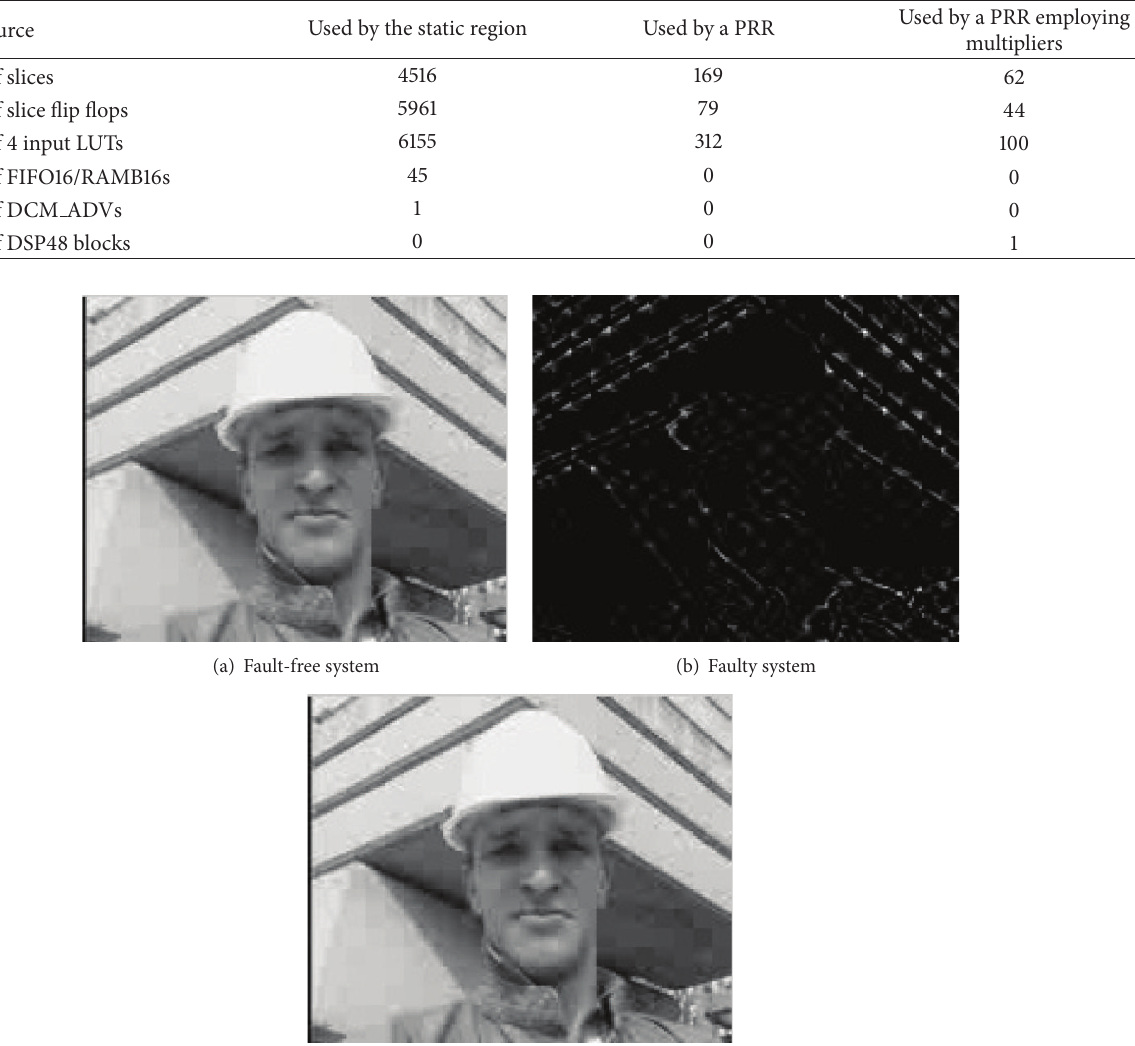
Table 2: Resource utilization summary of the DCT core.